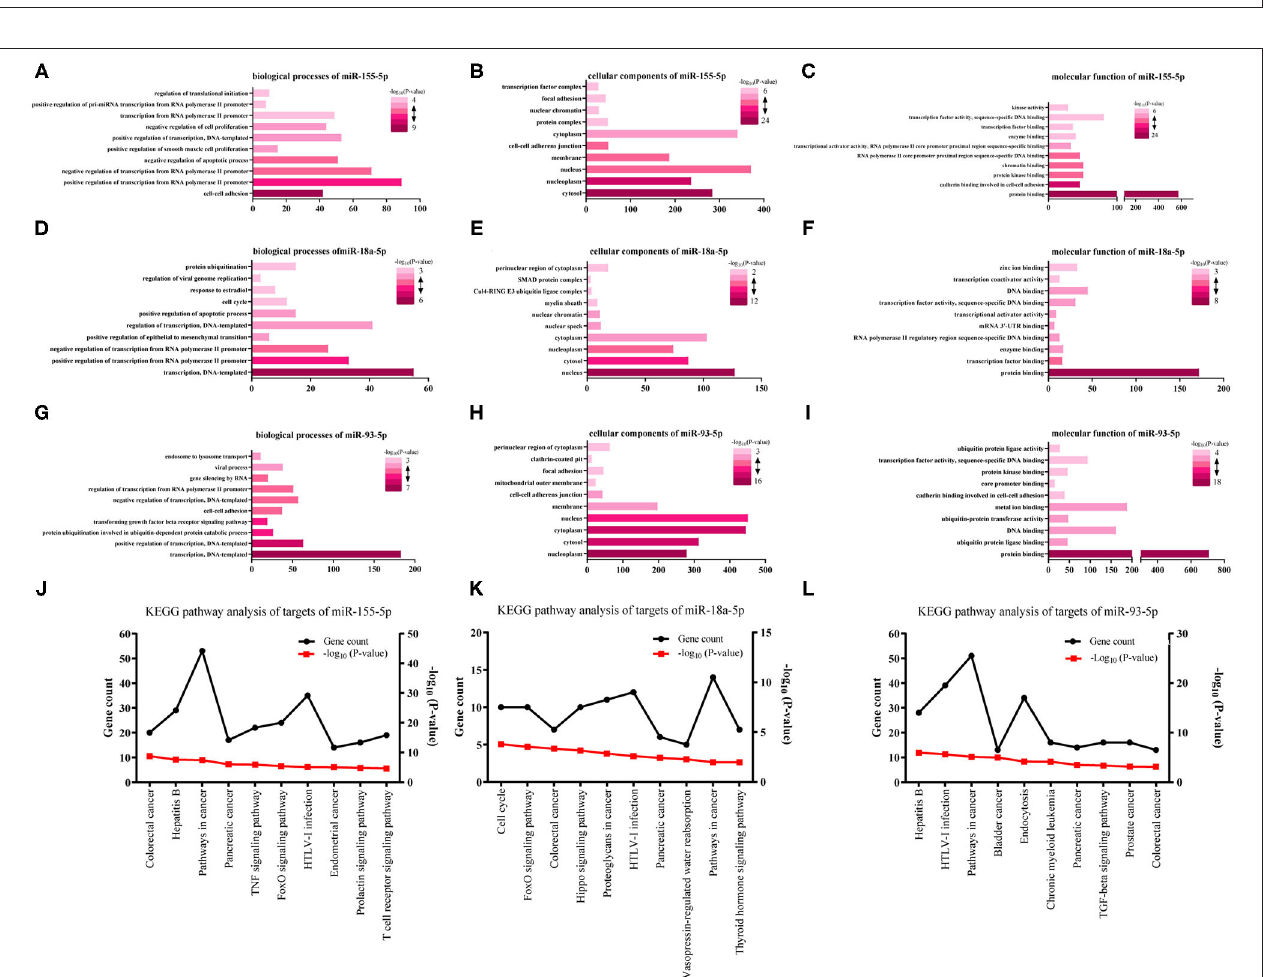
FIGURE 2 | The analysis of GO functions and KEGG pathway for three survival-associated miRNAs target genes. (A,D,G) The top 10 enriched biological processes of miR-155-5p, miR-18a-5p, and miR-93-5p; (B,E,H) The top 10 enriched cellular components of miR-155-5p, miR-18a-5p, and miR-93-5p; (C,F,I) The top 10 enriched molecular function of miR-155-5p, miR-18a-5p, and miR-93-5p. (J–L) KEGG pathway analysis for miR-155-5p, miR-18a-5p, and miR-93-5p. The black lines stand for gene count and the red lines stand for–log 10 ( P -value).